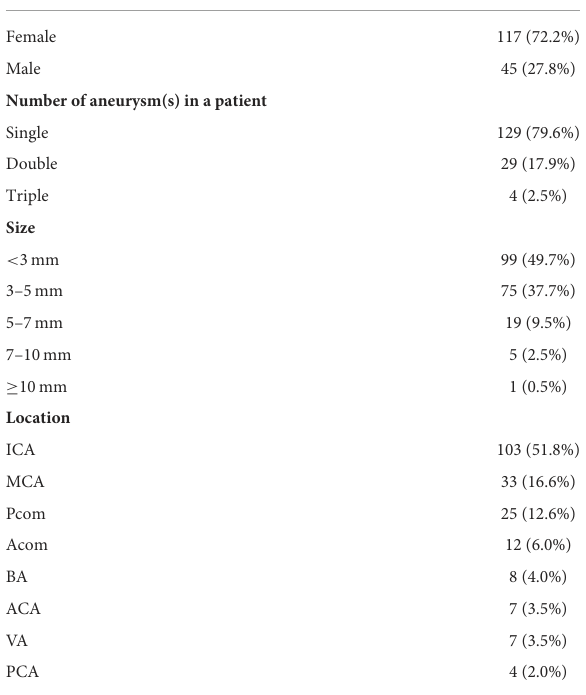
TABLE 2 TOF-MRA features of intracranial aneurysms. TABLE 3 TOF-MRA features of significant extra- and intracranial artery